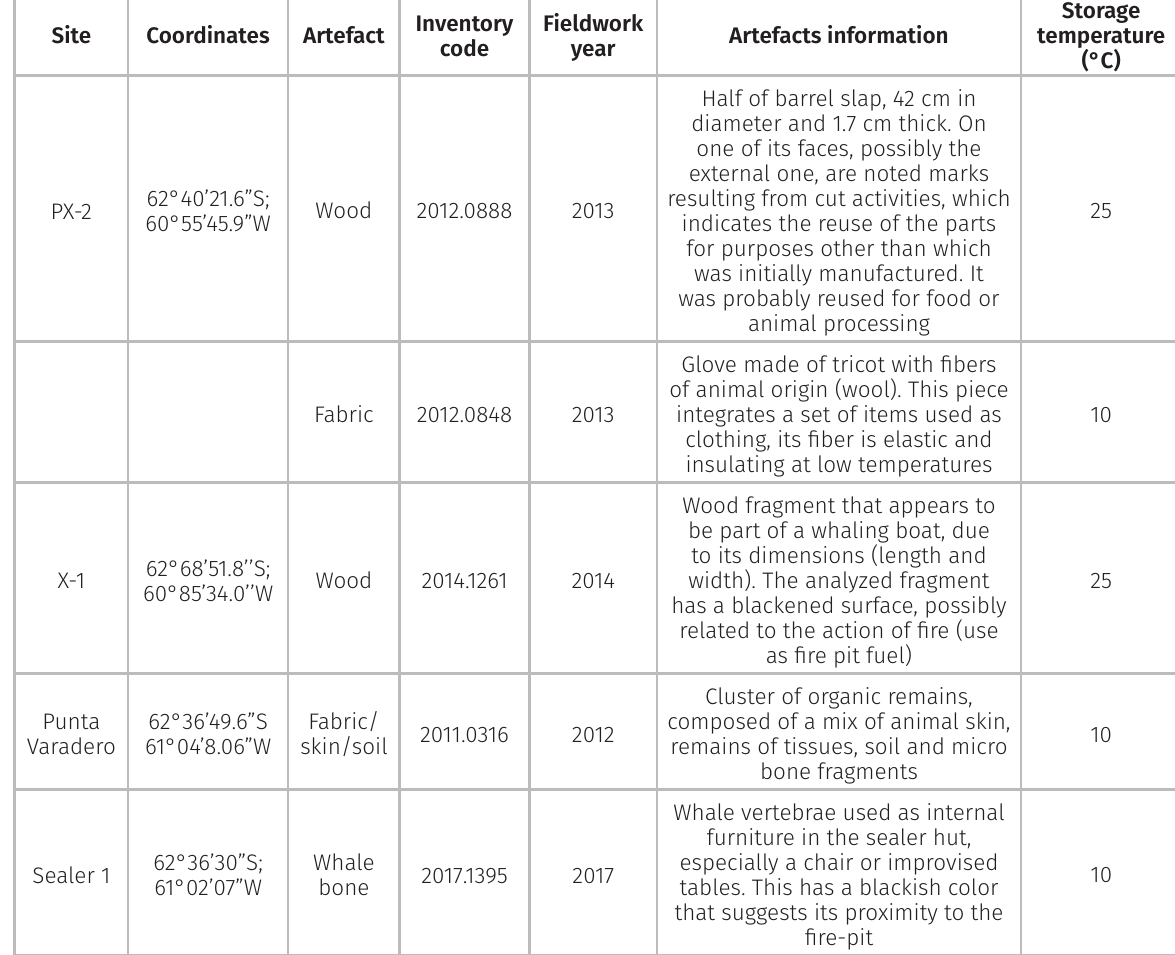
Table I. Artefacts sampled in the archaeological sealer site on Byers Peninsula, Livingston Island, South Shetland Island,